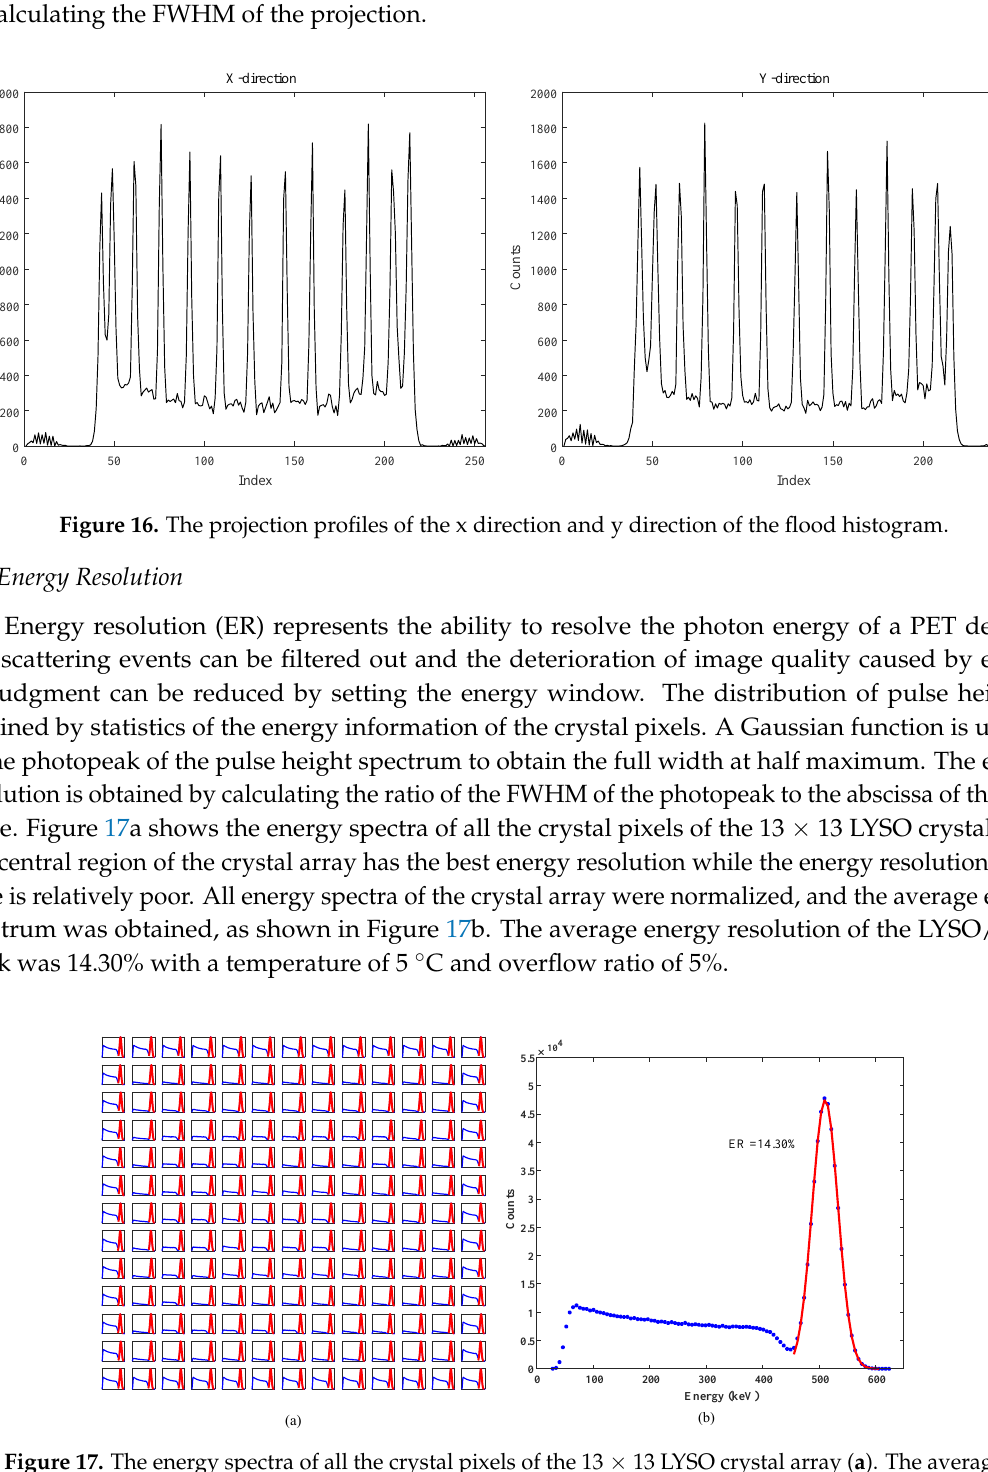
Figure 17. The energy spectra of all the crystal pixels of the 13 × 13 LYSO crystal array ( a ). The average energy spectrum of one LYSO/SiPM block ( b ). An average energy resolution of 14.30% was